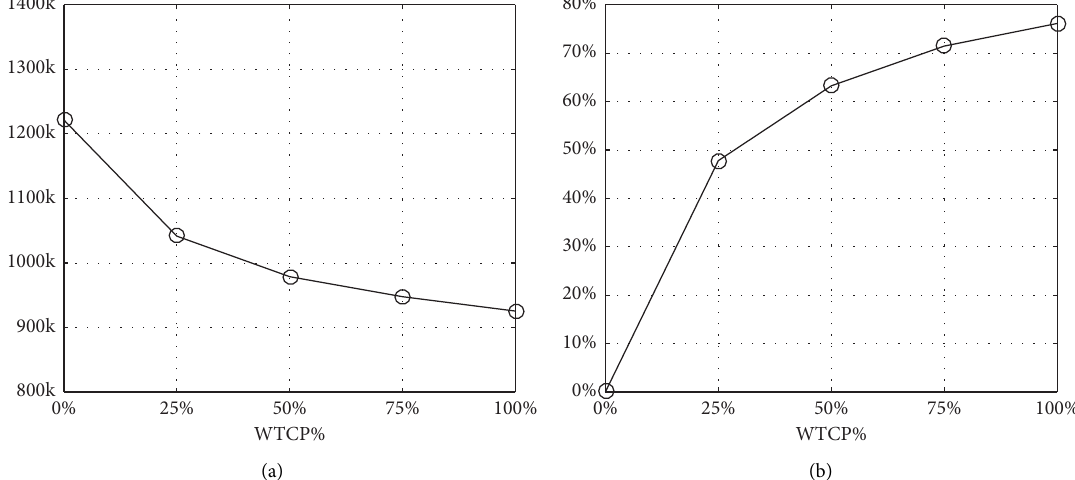
Figure 8: Total cost (a) and proportion of packages transported by taxi on spoke links (b) with different WTCP% (independent from payments for